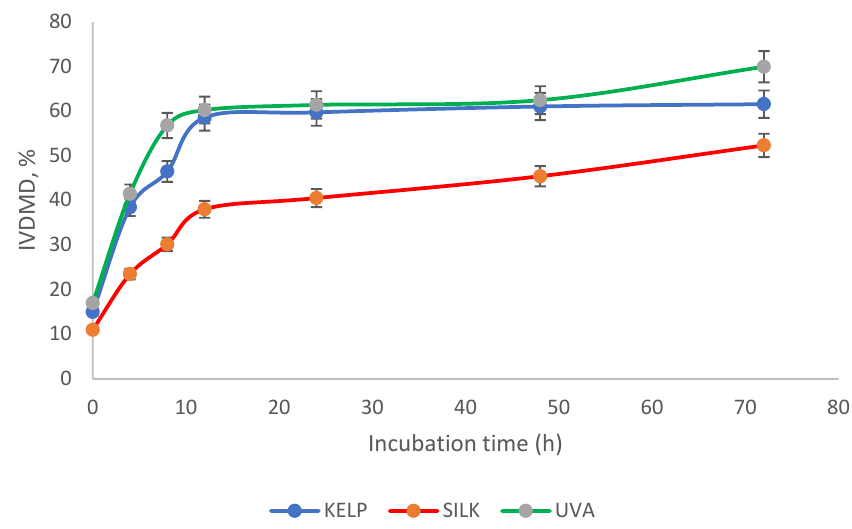
Figure 2. In vitro dry matter degradability of the Kelp, Silk, and Ulva algae after 72 h. The volume of gas produced (V) presents a significant ( p < 0.05) difference between treatments, with Kelp and Ulva algae (63.7 and 44.37), having a greater in vitro volume production compared to Silk alga (30.33). The lag phase was prolonged ( p < 0.05) with Kelp algae. Silk algae present a higher ( p > 0.05) gas production rate than the other treatments. The proportional production of CH 4 and CO 2 was affected ( p < 0.05) by the type of algae used (Table 3). Table 3. In vitro cumulative gas production and estimated kinetic parameter model for Kelp, Ulva, and Silk algae. Kelp Ulva Silk SEM The volume of gas produced (v), mL Production rate (s), mL/g −